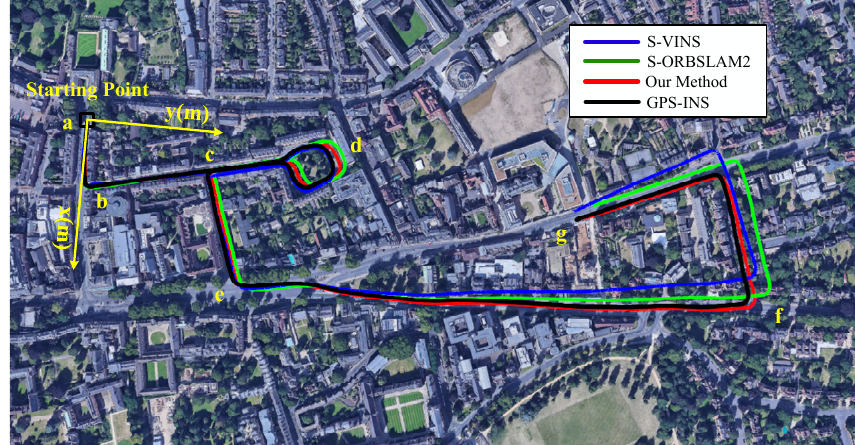
Figure 12. Trajectories of 3 methods comparing with the ground truth on the Google earth map. The results show that our proposed method can have smaller overall errors compared with other state-of-the-art methods